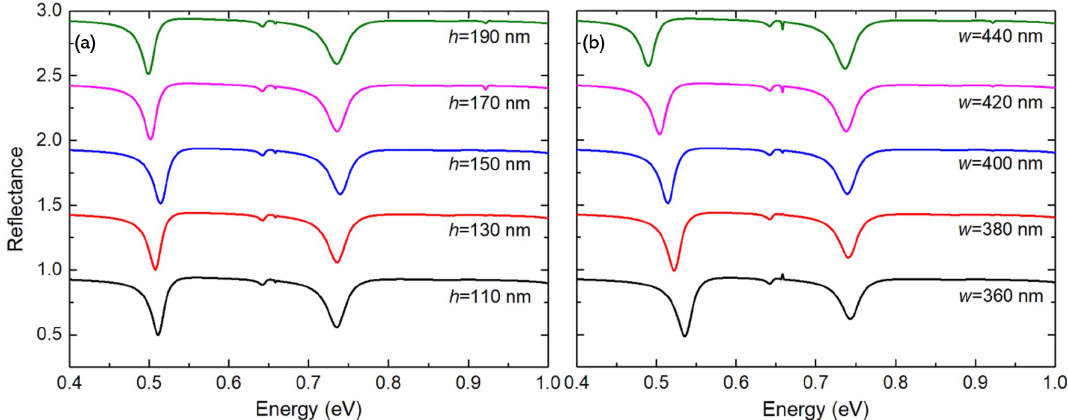
Figure 5. Simulated reflectance spectra of the proposed plasmonic-photonic system with different ( a ) nanorod heights h and ( b ) side widths w